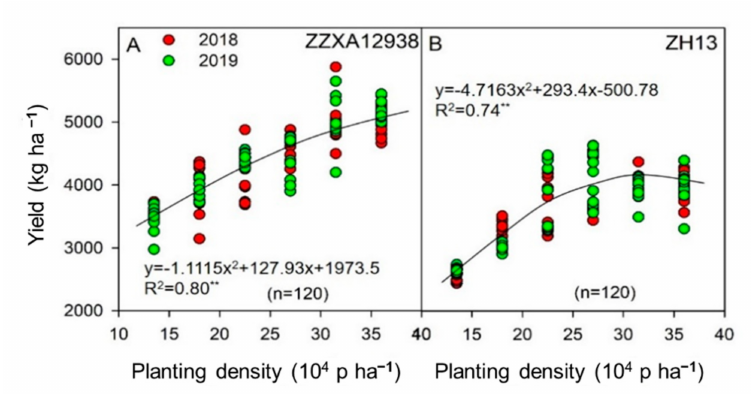
Figure 4. The relationship between yield and planting density for ( A ) ZZXA12938 and ( B ) ZH13. Markers with different colors represent different growing seasons; ** indicates that the correlation is significant at the p ≤ 0.01